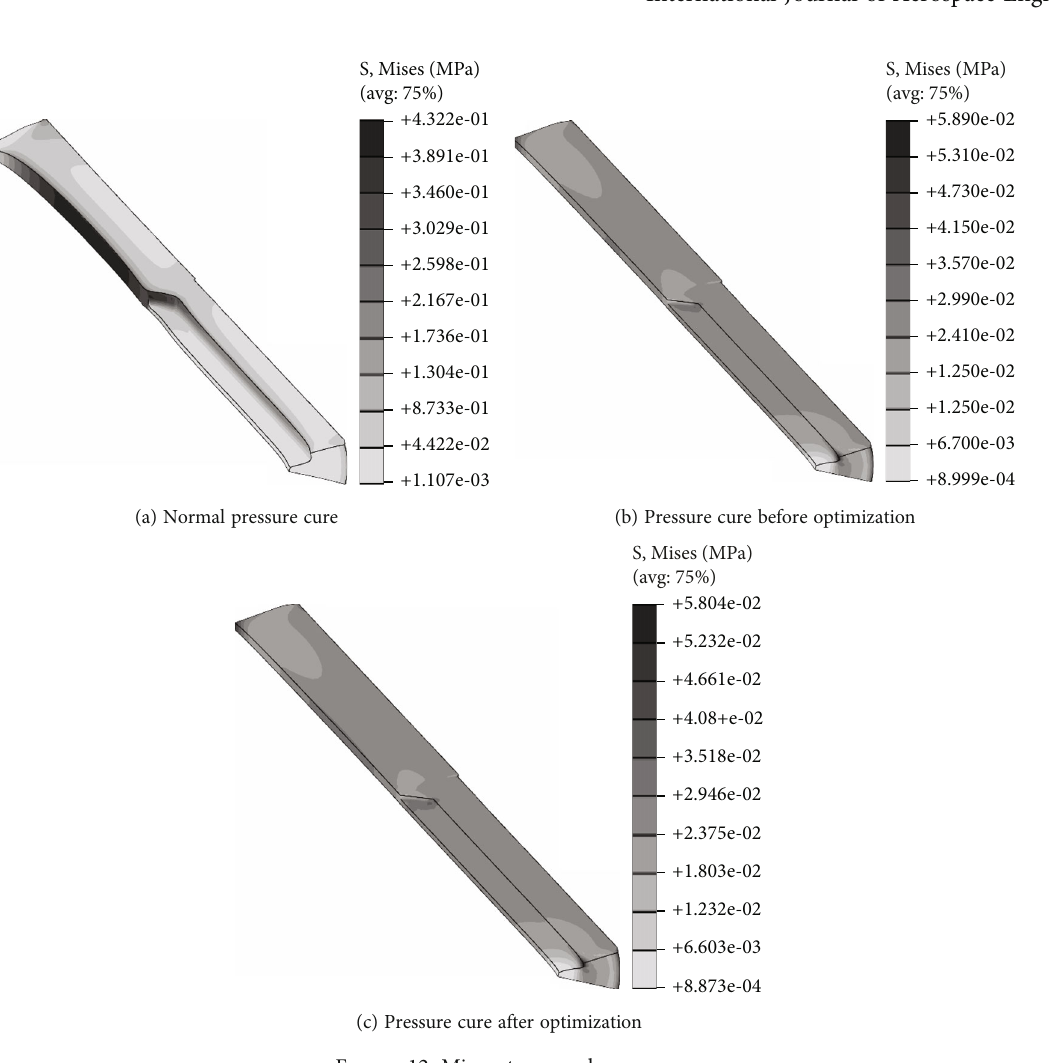
Figure 12: Mises stress